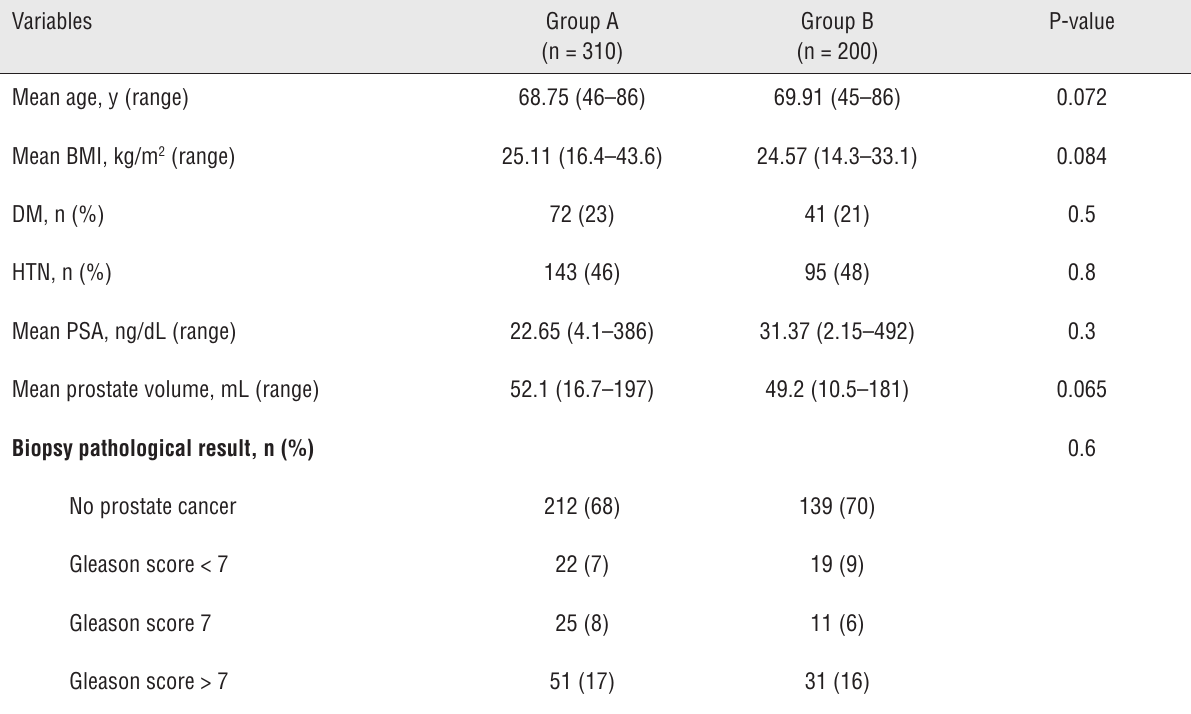
Table 1 - Demographic data of the 510 patients stratified in accordance with adequate rectal preparation (Group A) and traditional rectal preparation (Group